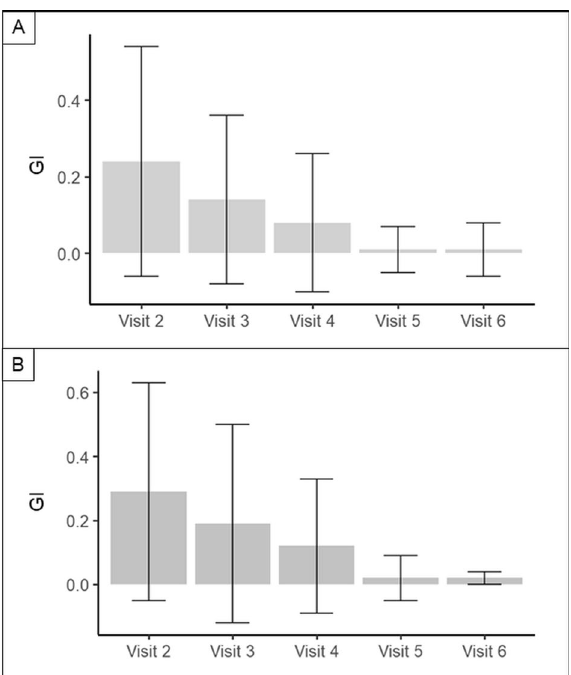
Figure 5. GI from visit 2 to visit 6. A represents the HAP-group, while B shows the fluoride-group. In both groups the GI decreased significantly. There was no difference between the HAP and the